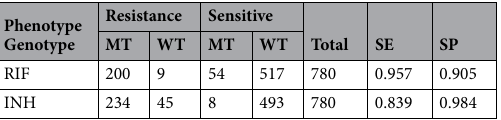
Table 1. The summary of the Phenotypic DST and Molecular DST of the isolates. KEY: RIF =